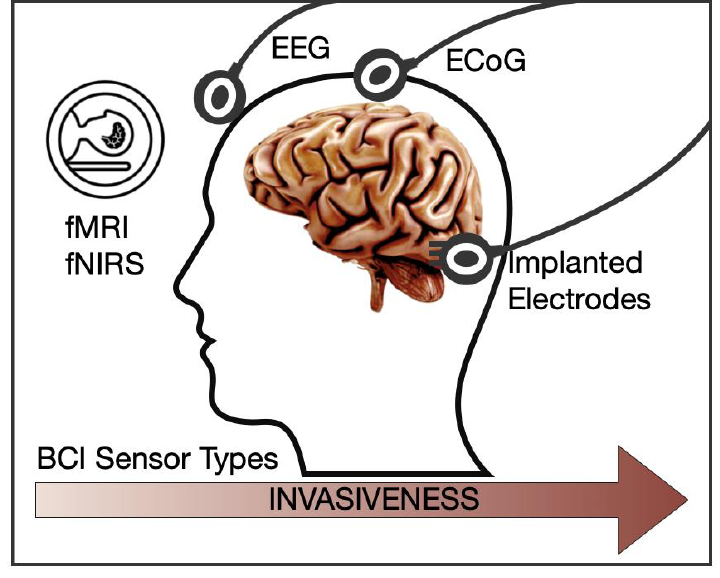
Figure 4. BCI-sensors types [148,149]. Table 2. Summary of the most popular sensors applied in BCIs [148]. Sensor Type Spatial Resolution Temporal